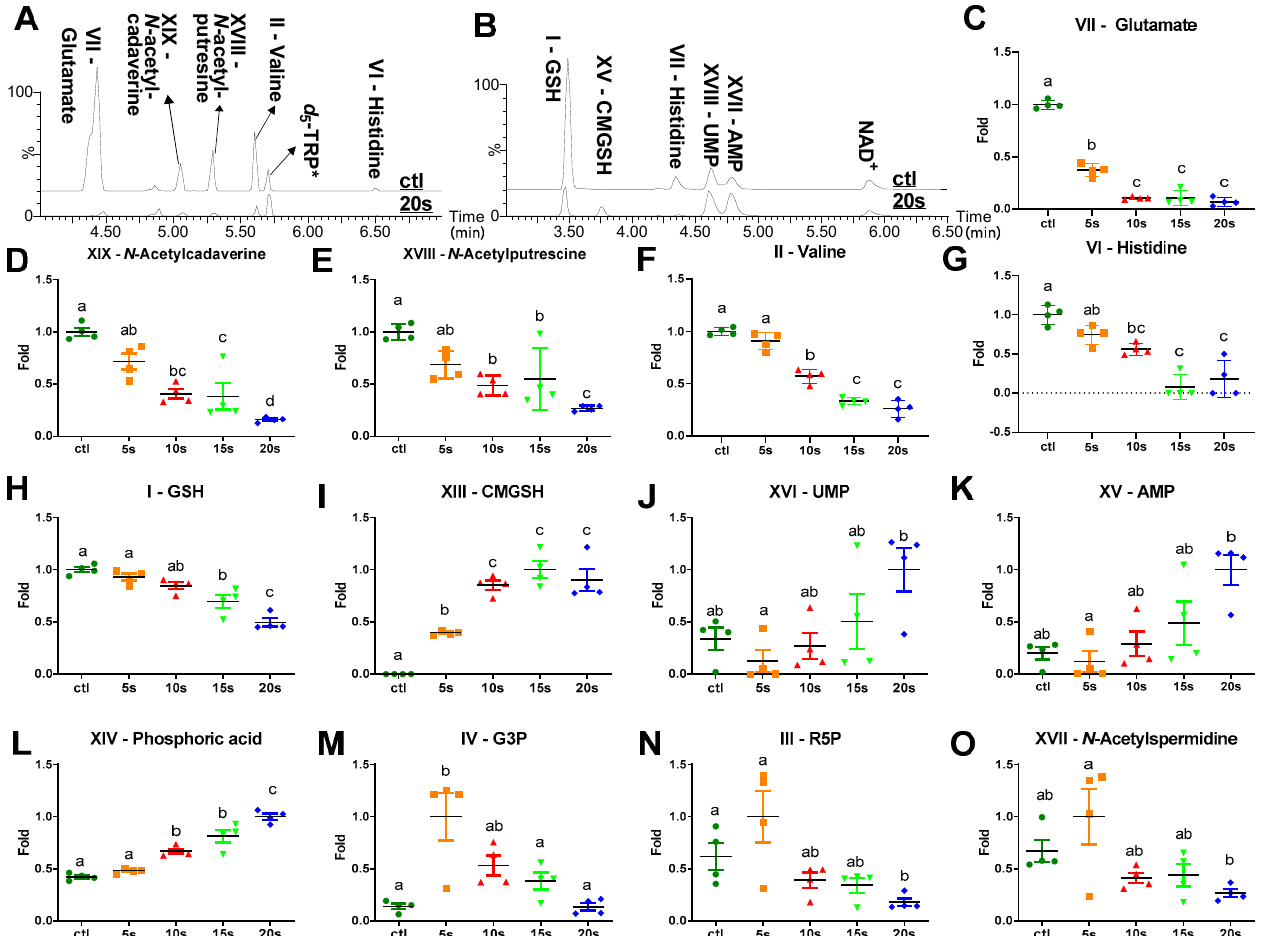
Figure 4. Influences of IPL treatment on cytoplasmic metabolites. ( A ) Representative chromatographs on amino acid metabolites in the aqueous fractions of control and IPL-treated E. coli (20 s). These metabolites were detected via dansyl chloride derivatization. d 5 -TRP ( d 5 -tryptophan) was the internal standard in amino acid analysis and had stable signals across all the samples. ( B ) Representative chromatographs on hydrophilic metabolites in the aqueous fractions of control and IPL-treated E. coli (20 s). These metabolites were detected in the negative ionization mode without derivatization. The relative abundances of cytoplasmic metabolite markers across all the samples were compared by arbitrarily setting the average of the treatment group with the highest relative abundances as 1. The peak of NAD + is included in the chromatograph for its relative stable signals across all the samples: ( C ) glutamate; ( D ) N -acetylcadaverine; ( E ) N -acetylputrescine; ( F ) valine; ( G ) histidine; ( H ) GSH, glutathione; ( I ) CMGSH, S-carboxymethyl-glutathione; ( J ) UMP, uridine monophosphate; ( K ) AMP, adenosine monophosphate; ( L ) phosphoric acid; ( M ) G3P, glycerol 3-phosphate; ( N ) R5P, ribose 5-phosphate; and ( O ) N -acetylspermidine. Different letters (a–d) indicate significant differences ( p < 0.05).